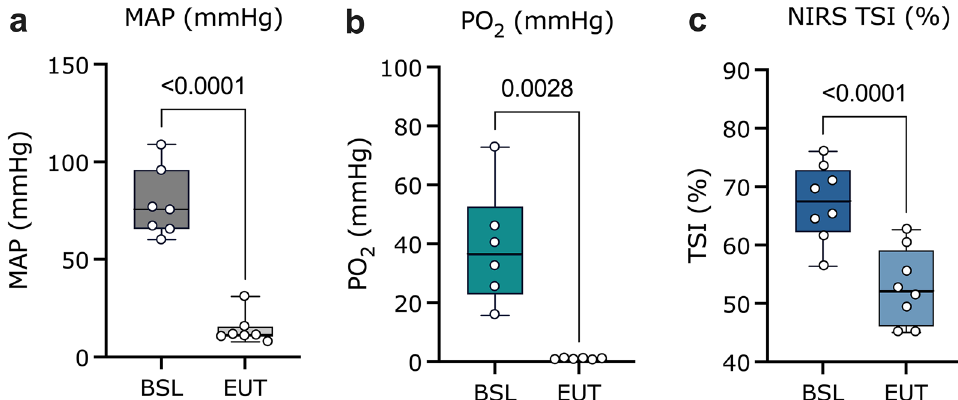
Figure 3. Pre- and post-euthanasia comparison of carotid MAP, spinal cord PO 2 and TSI (%) measures. Box plots (IQR + min and max values) of pre-euthanasia (BSL; averaged over 60 s pre-pentobarbital infusion) and post-euthanasia values (EUT; averaged over the last 10 s of the recording) in ( a ) MAP (mmHg) (n = 7, p < 0.0001) ( b ) spinal cord PO 2 (mmHg) (n = 6, p = 0.0028, and ( c ) TSI (%) (n = 8, p < 0.0001). Group comparisons were analyzed using a paired student’s t-test (level of significance p < 0.05). TSI (%) tissue saturation index, MAP mean arterial pressure, PO 2 partial pressure of oxygen, BSL baseline, EUT euthanasia.